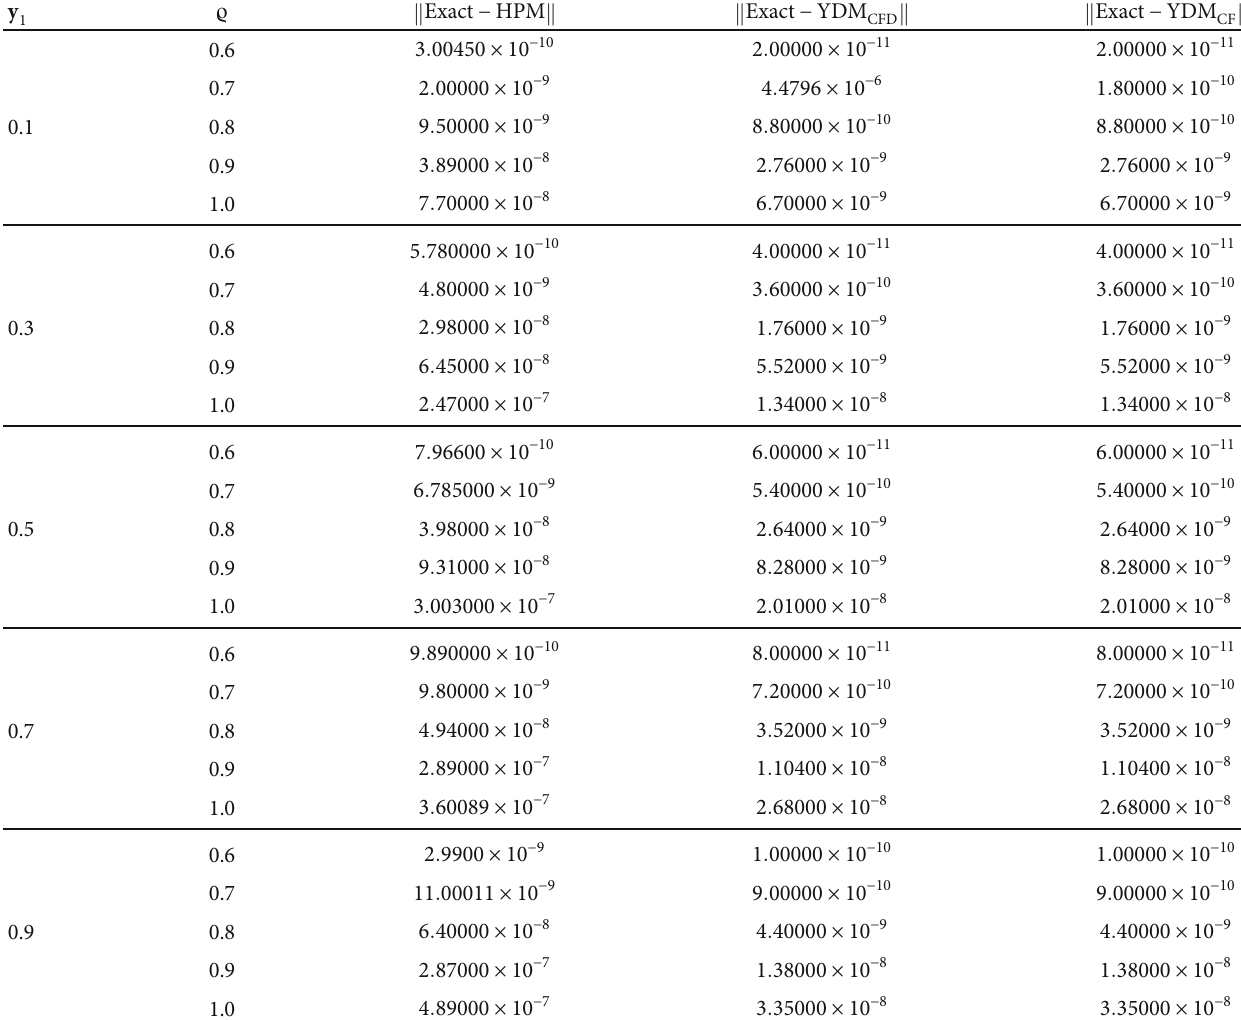
, ϱ Þ at δ = 1 considering multiple choices of y 1